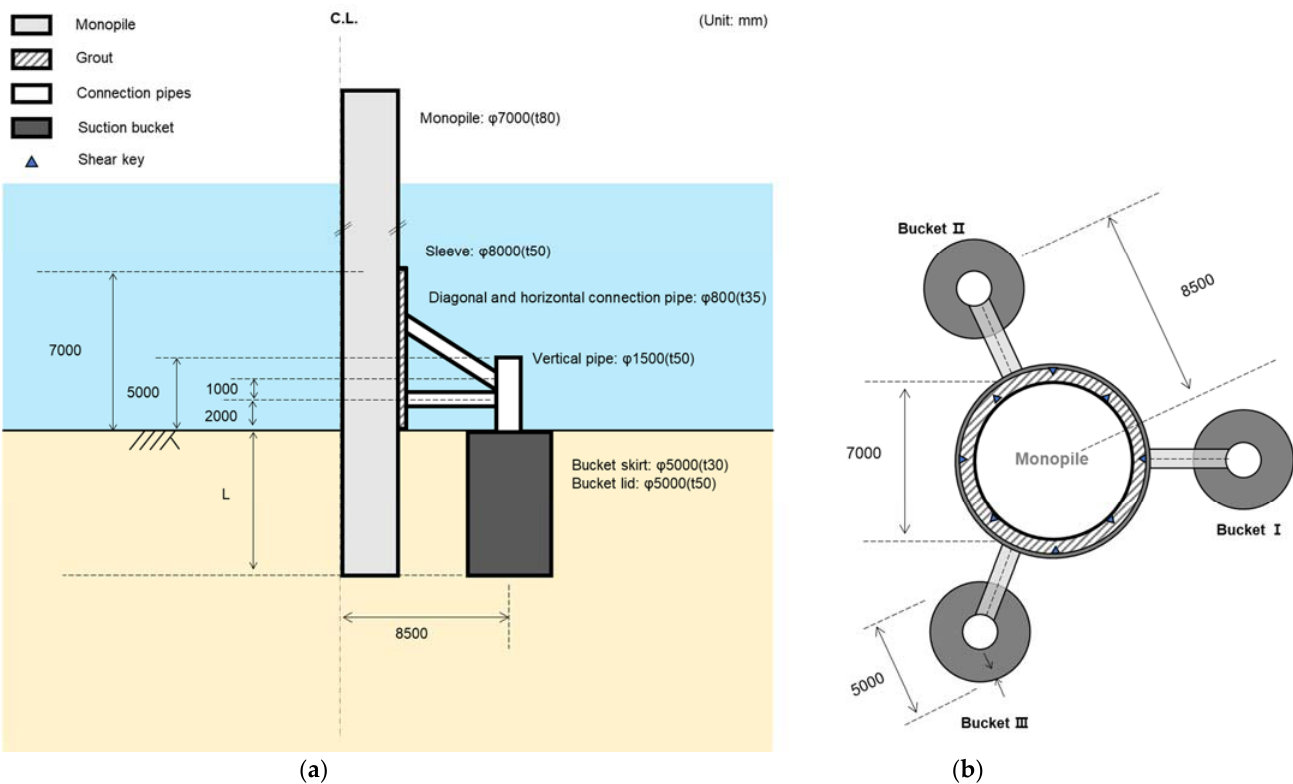
Figure 1. Scheme of hybrid foundation combining with a monopile and tri ‐ buckets: ( a ) side view; ( b ) top view, where C.L.: centerline of the hybrid monopile, L: embedding length of the monopile, φ : diameter of the cross ‐ section of structural members.